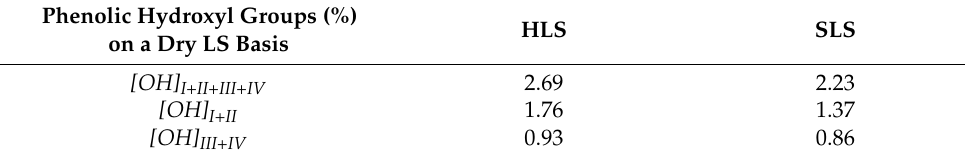
Table 2. Content of phenolic hydroxyl groups of the HLS and SLS samples.